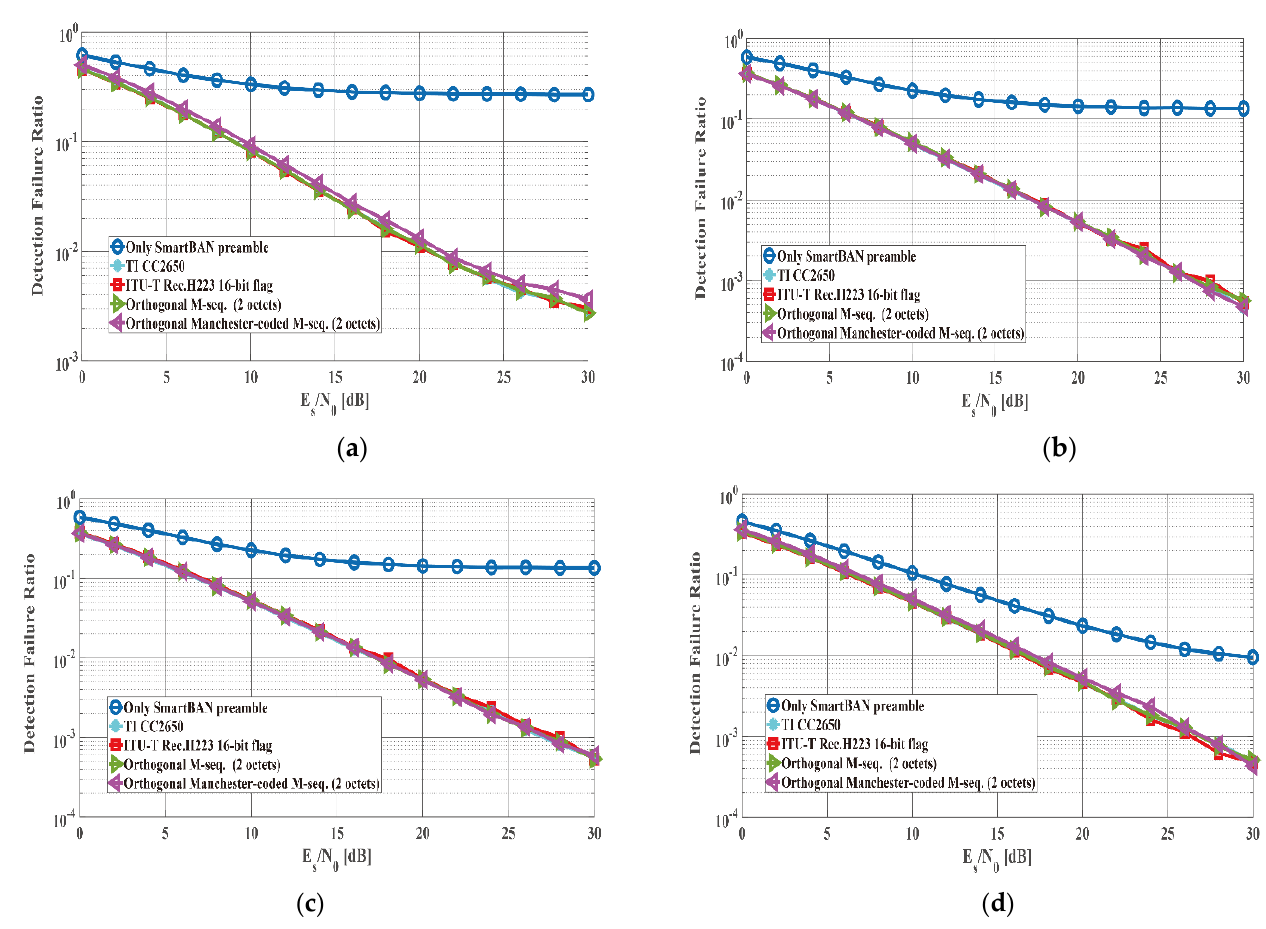
Figure 8. PLCP header detection failure ratio in the case of several modulation schemes under the IEEE channel CM3 (strong shadowing case, K = 0.14). ( a ) GFSK (SmartBAN). ( b ) QPSK. ( c ) 𝜋 4⁄ -DQPSK. ( d ) D8PSK.